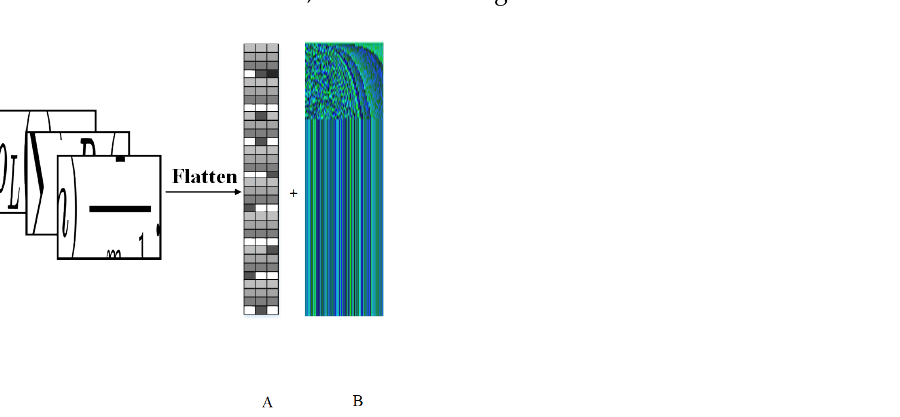
Figure 4. Positional embedding; ( A ) represents the flattened image blocks; ( B ) represents the posi- tion